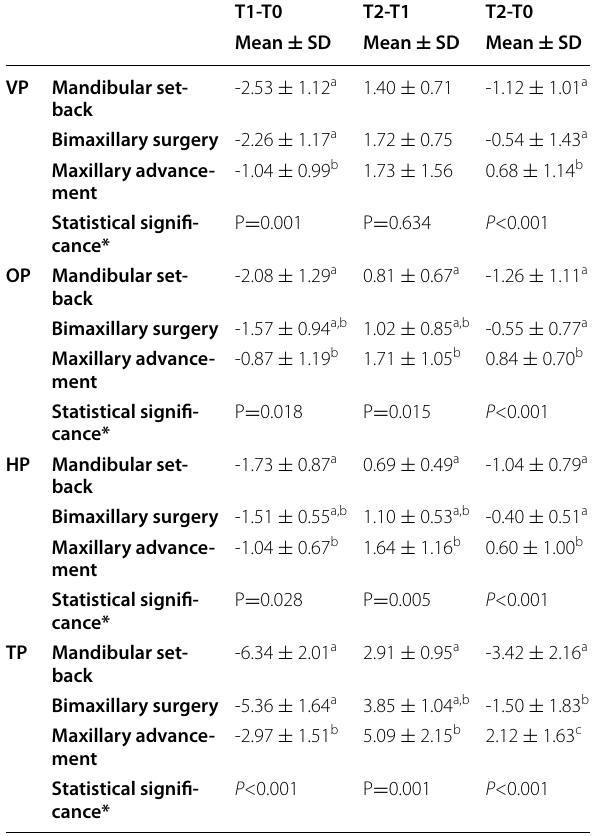
Table 3 The mean and standard deviation (SD) for alterations in velopharyngeal (VP), oropharyngeal (OP), hypopharyngeal (HP), and total pharyngeal (TP) dimensions between the study